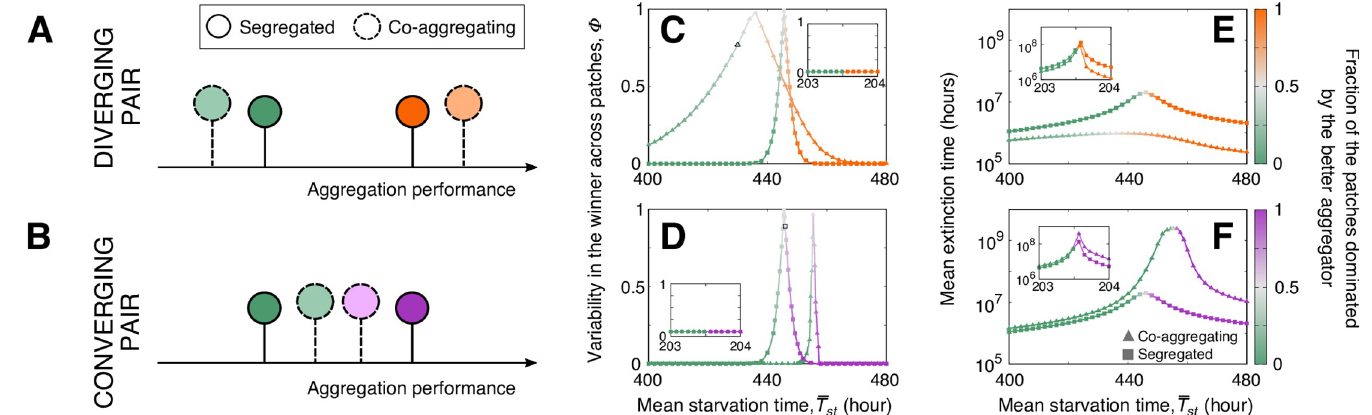
Fig 5. Ecological implications of developmental interactions. (A, B) Codevelopment makes strains (different colors) diverge (A) or converge (B) in their partitioning behavior. (C–F) Effect of coaggregation versus segregated development on (C, D) the identity of the winner (Eq 6 in Materials and Methods) and (E, F) extinction times as a function of environmental harshness (longer for larger � T ). Panels (C, E) and (D, F) are predictions for the pairs of strains in S8A and S8C Fig, respectively. Green st strain is the same across all panels. Main panels, stochastic environments; insets, deterministic environments (see Materials and Methods). Color gradients indicate the change in the fraction of patches dominated by each of the mixed strains. Parameterization as in S8A and S8C Fig.